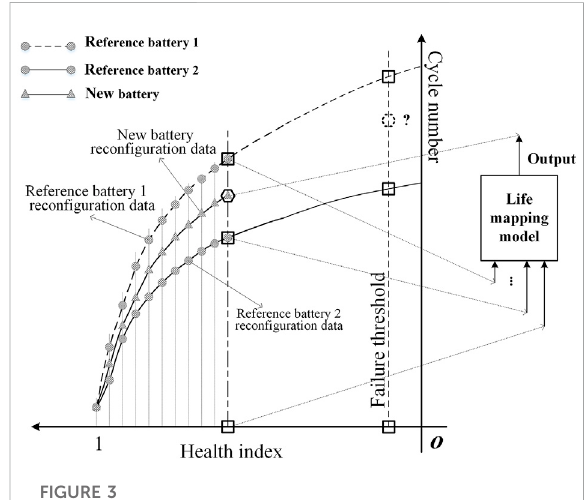
FIGURE 3 Schematic diagram of life prediction modeling.